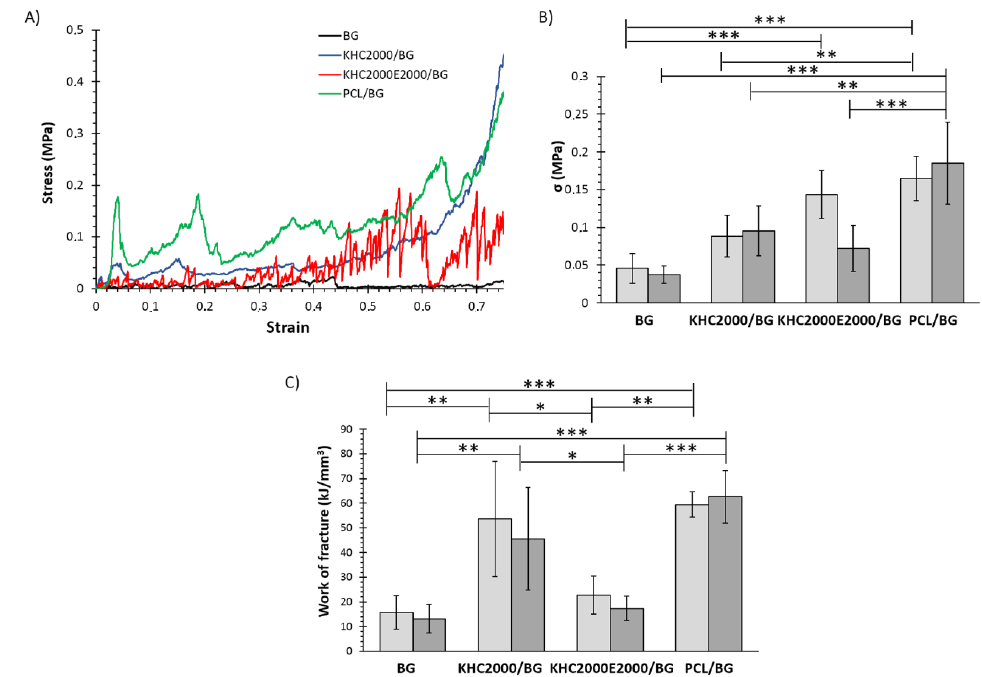
Figure 12. Mechanical characterization of BG, KHC2000/BG, KHC2000E2000/BG, and PCL/BG after 21 days immersion in SBF. ( A ) Representative stress-strain curves of BG, KHC2000/BG, KHC2000E2000/BG, and PCL/BG, ( B ) compressive strength and ( C ) work of fracture calculated for each type of scaffold in dry (light gray) and wet (gray) conditions. * 0.01 < p < 0.05, ** 0.001 < p < 0.01, and *** 0.0001 < p < 0.001.